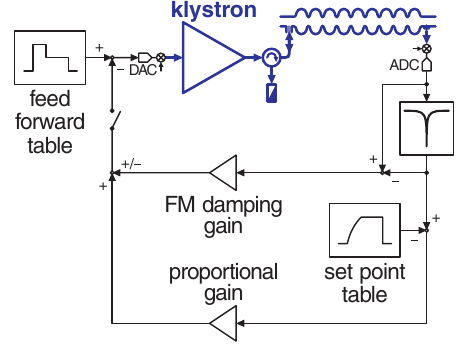
FIG. 14. (Color) Sketch of a pulsed rf superconducting cavity control loop with damping of an unwanted